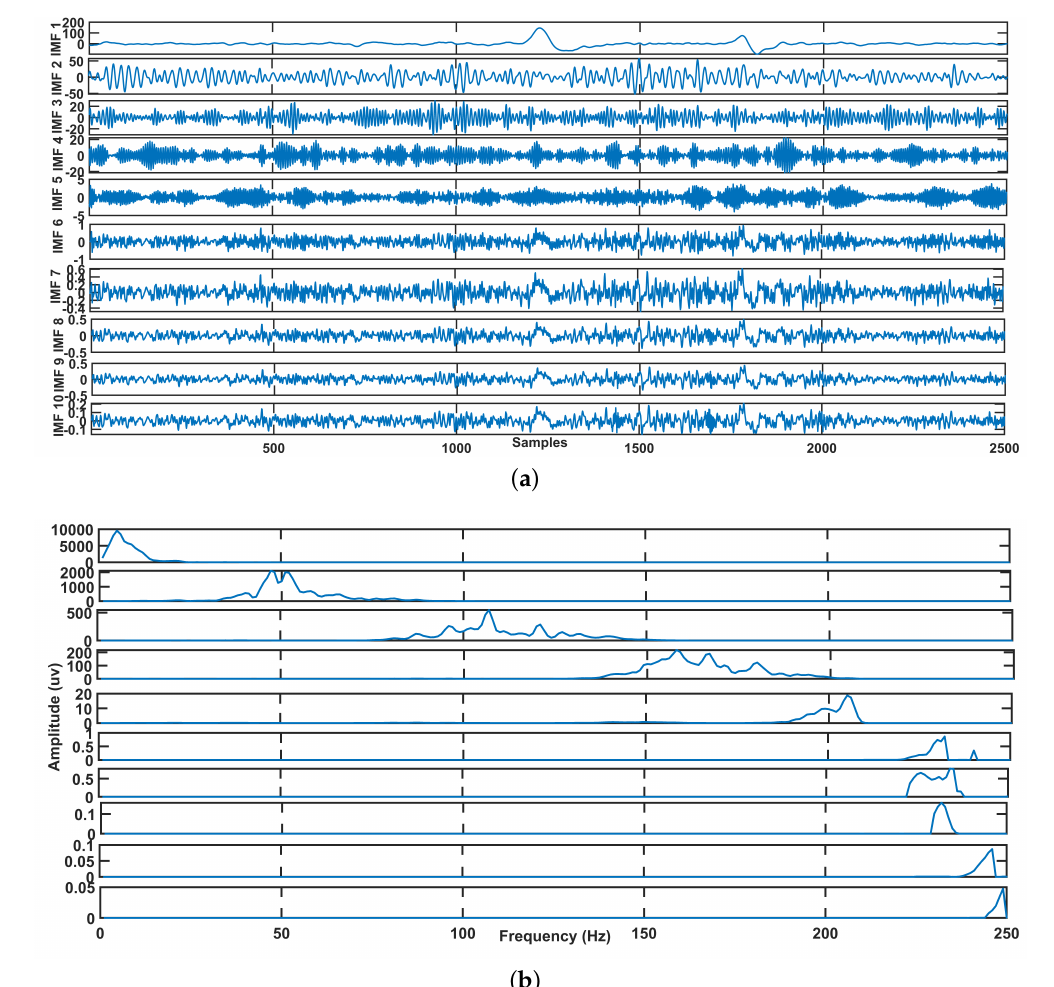
Figure 3. 10-level decomposition of EEG signal IMFs and PSD. ( a ) Decomposition of contaminated EEG signal using CiSSA. ( b ) Power Spectral